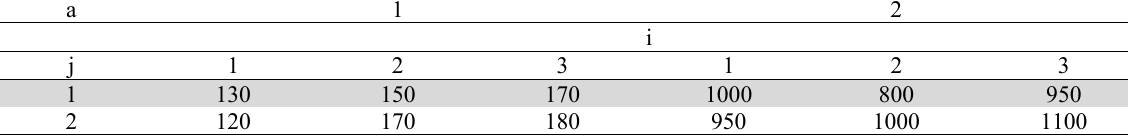
Distance between suppliers and plants(d a ij )(km)